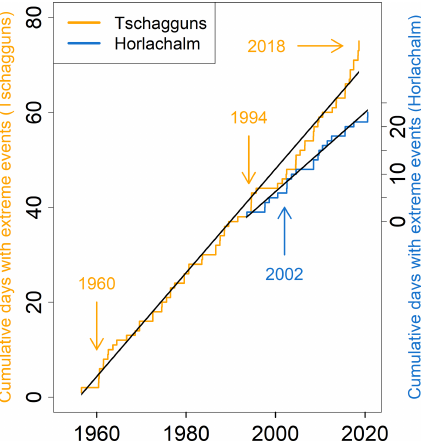
Figure 10. Cumulative sums of days with precipitation intensities exceeding 10mm per 30min for Tschagguns (orange) and Hor- lachalm (blue). Years with exceptionally many days with a high- intensity event (Tschagguns: four per year; Horlachalm: three per year) are